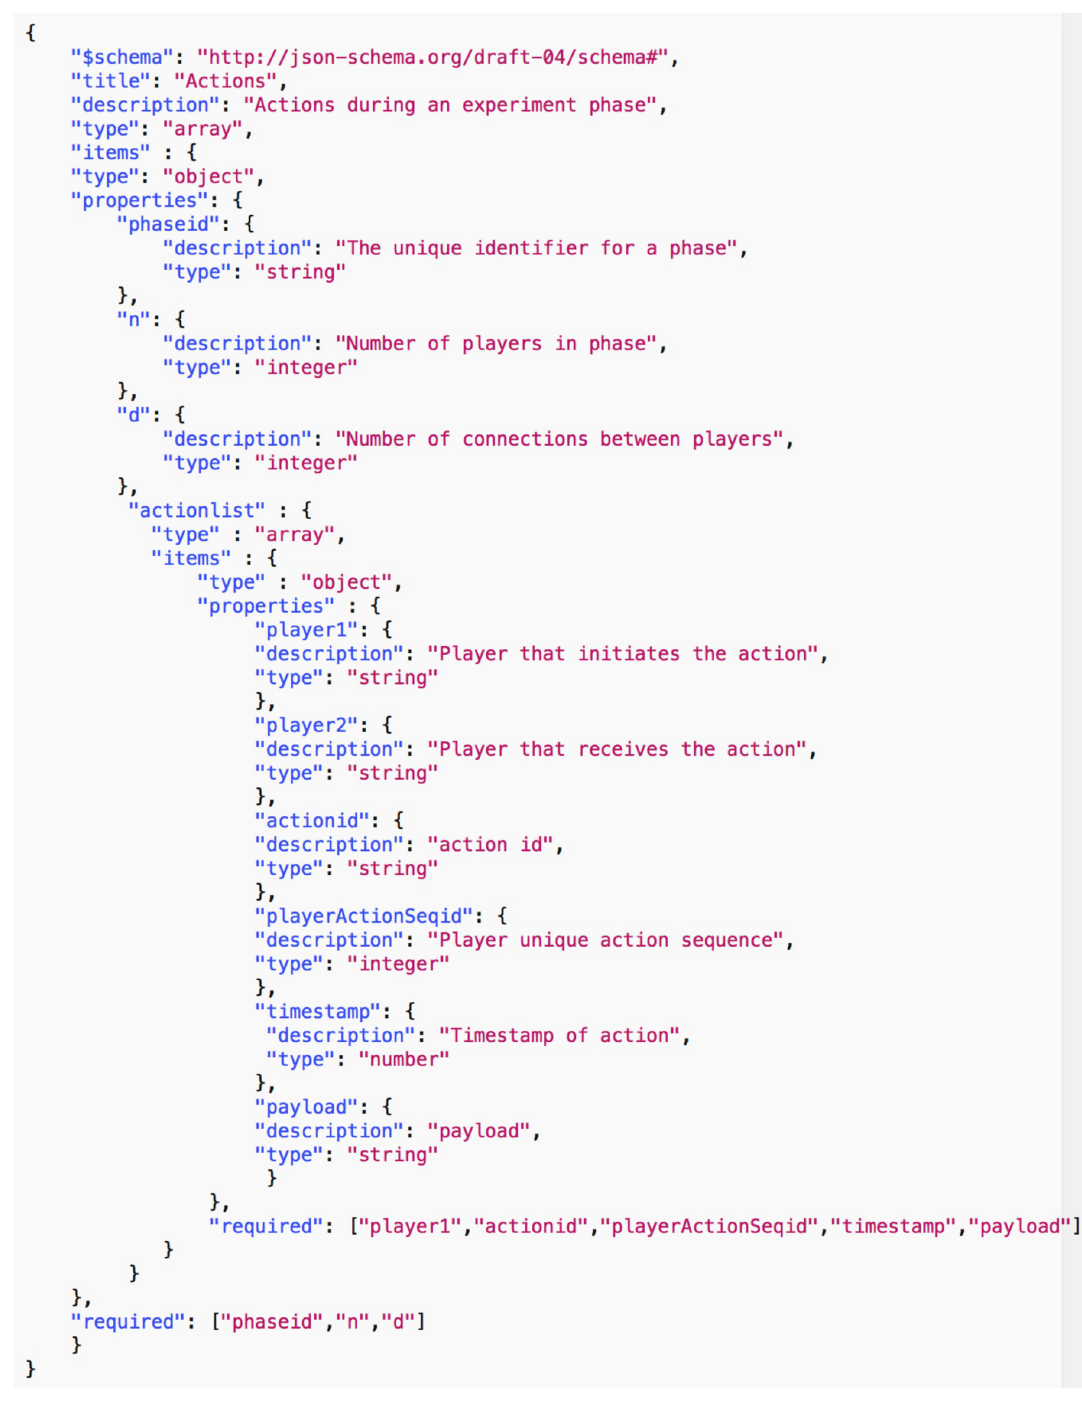
Fig 23. JSON schema for the “Action” of the data common specification.